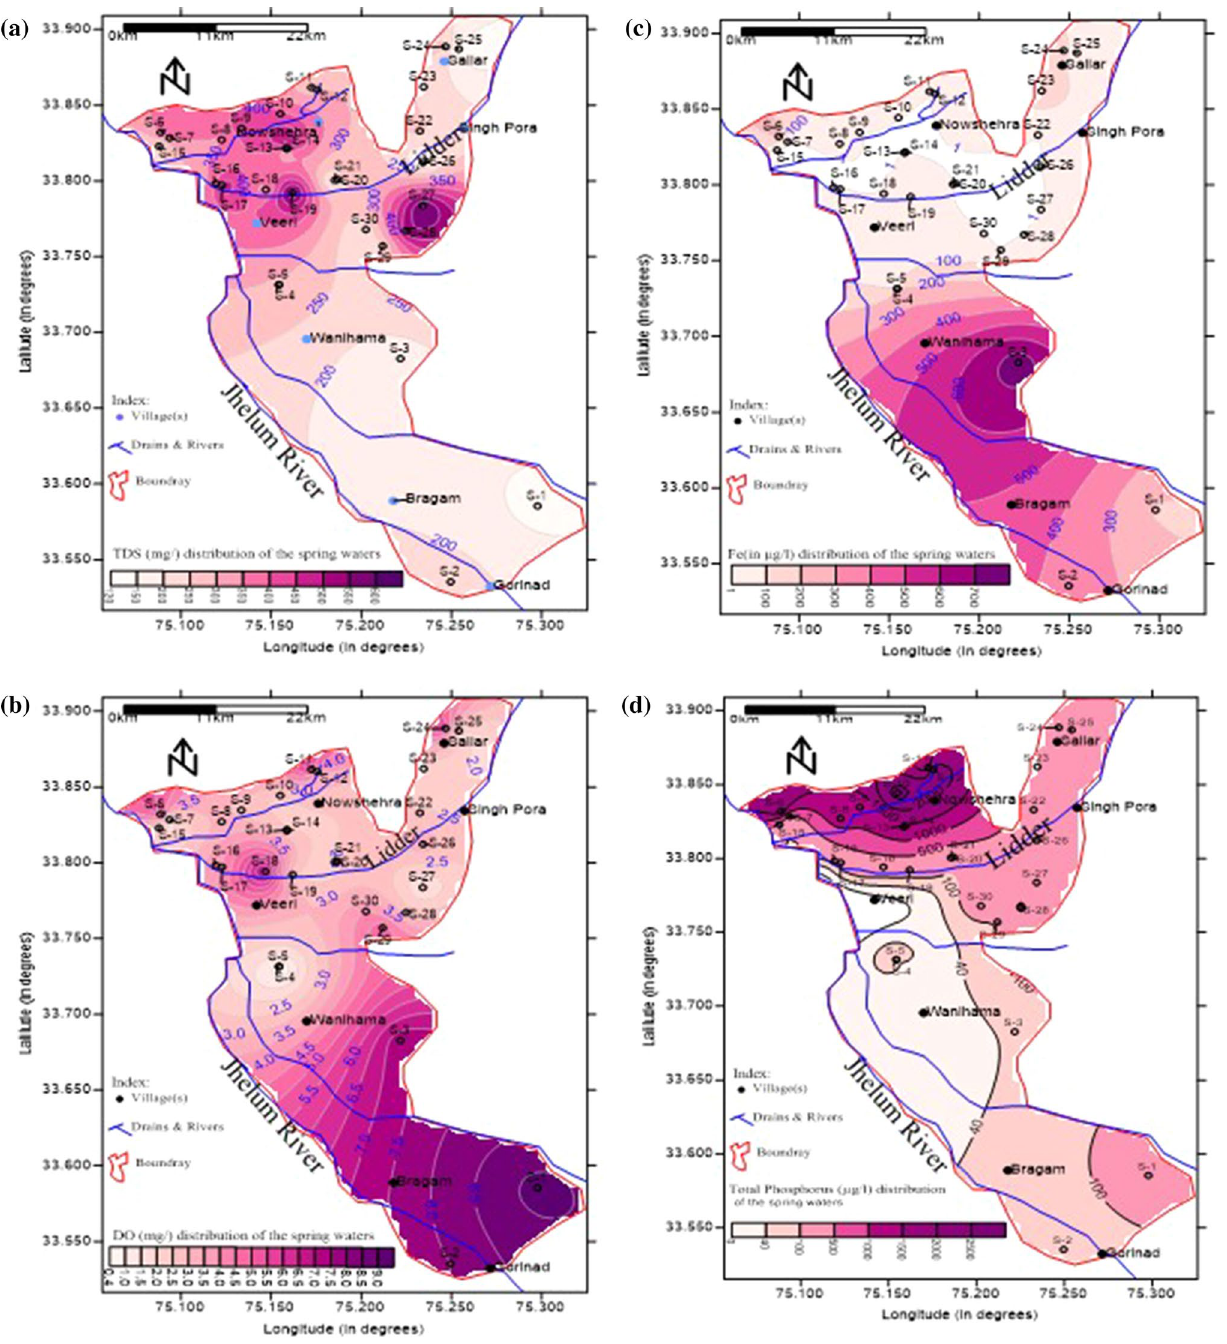
Fig. 4 Spatial distribution of a TDS, b DO, c Iron, and d Total phosphorus of the spring waters from a part of Anantnag district, Kashmir